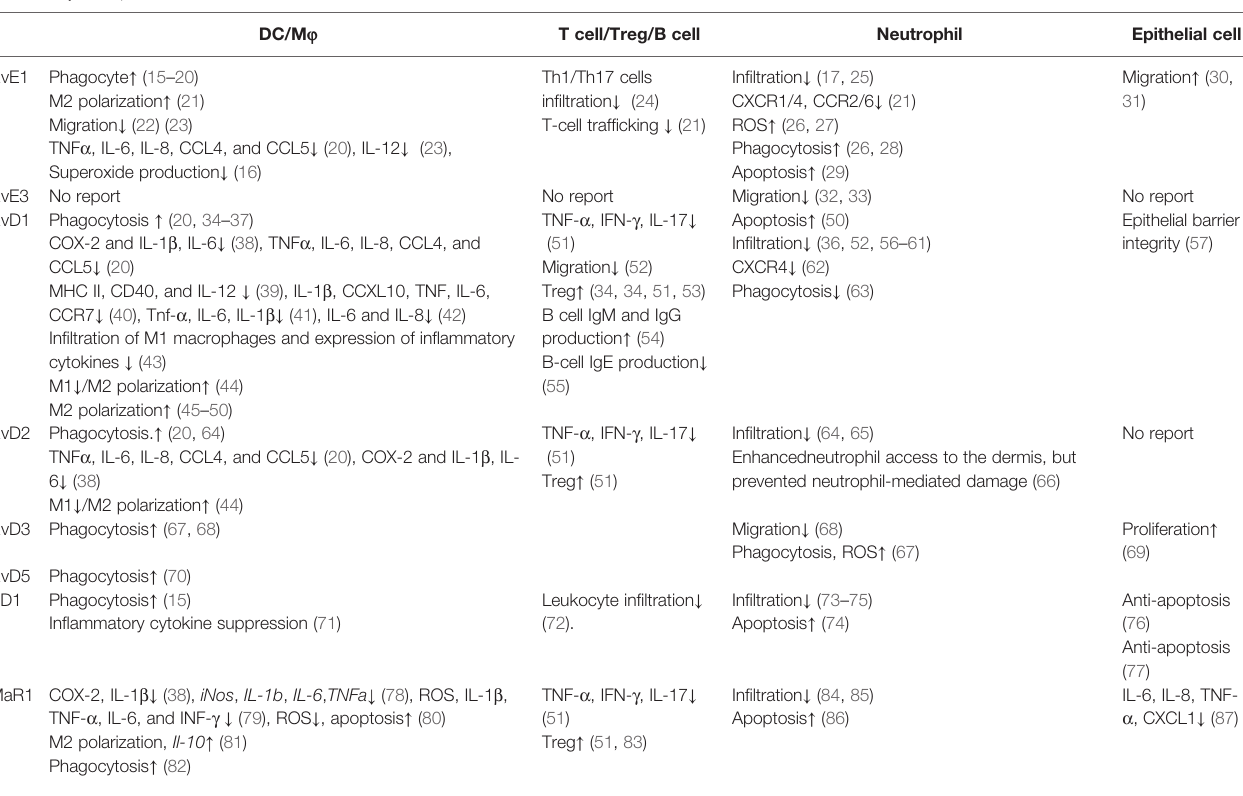
TABLE 1 | Cell speci fi c action of